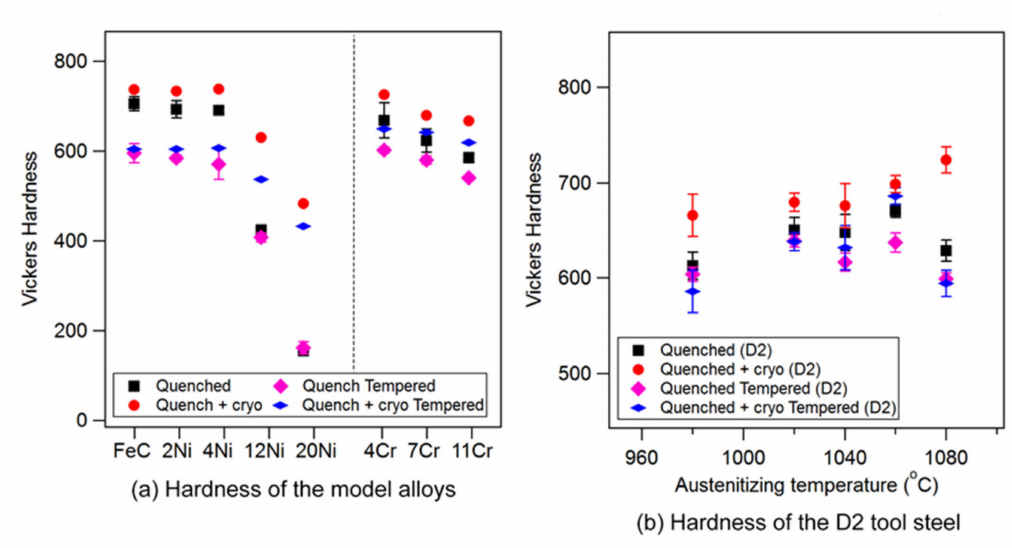
Figure 7. Vickers hardness of samples before and after tempering treatment.